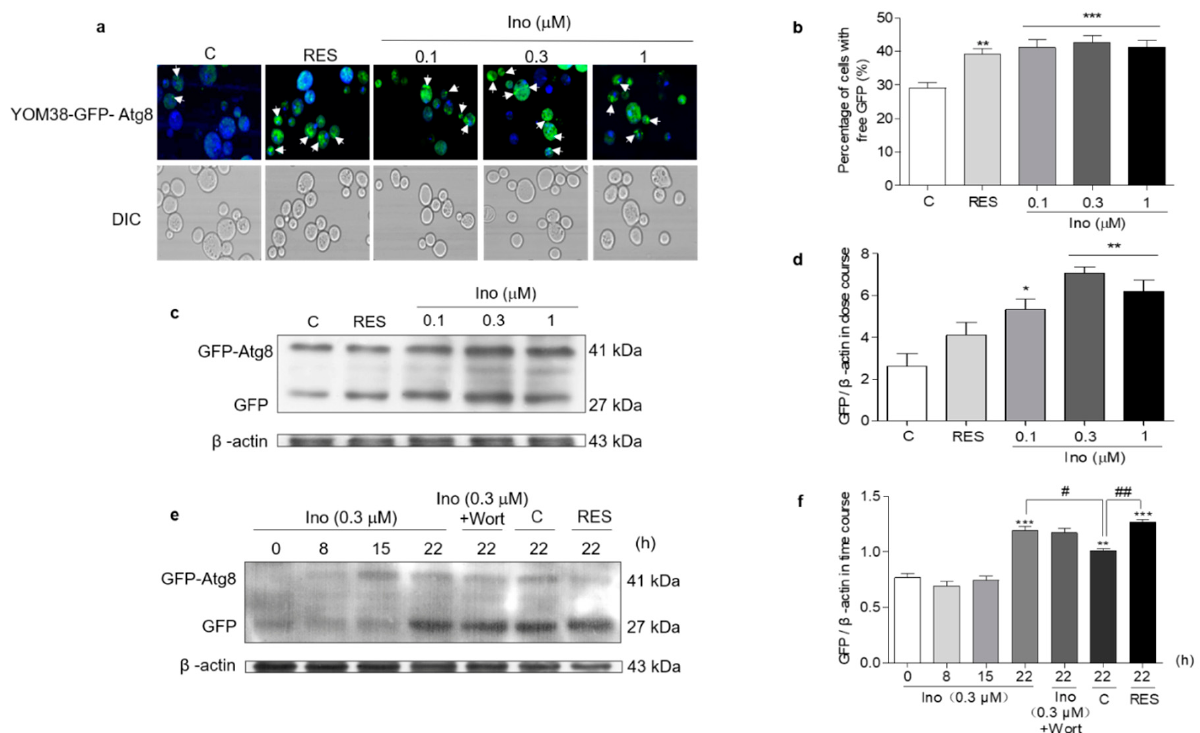
Figure 5. Effect of inokosterone on autophagy in yeast. ( a ) Fluorescent images of the YOM38 yeast- containing plasmid pRS316- GFP-ATG8 after treatment with RES at 300 µ M or inokosterone at 0.1, 0.3, and 1 µ M, as observed with a two-photon confocal fluorescent microscope. ( b ) The percentage of YOM38 cells containing free-GFP (green). Ten pictures containing more than 60 cells in each group were used for the statistical analysis. ** p < 0.01, and *** p < 0.001 represent significant difference compared with the control group. ( c ) The Western blot analysis of GFP-Atg8 and free GFP in yeast after treatment with RES at 300 µ M or inokosterone at 0.1, 0.3, and 1 µ M for 22 h. ( d ) The digital results of ( c ). * p < 0.05 and ** p < 0.01 represent significant differences compared with the control group. ( e ) The Western blot analysis results for the GFP-Atg8 and free GFP in yeast after treatment with RES at 300 µ M, wortmannin at 200 nM, or inokosterone at 0.3 µ M in the time course. ( f ) The digital results of ( e ). ** p < 0.01, and *** p < 0.001 represent significant differences compared with the 0 h group. # p < 0.05 and ## p < 0.01 indicate significant differences compared with control group at 22 h. The experiments were repeated thrice, and the data are presented as the mean ±